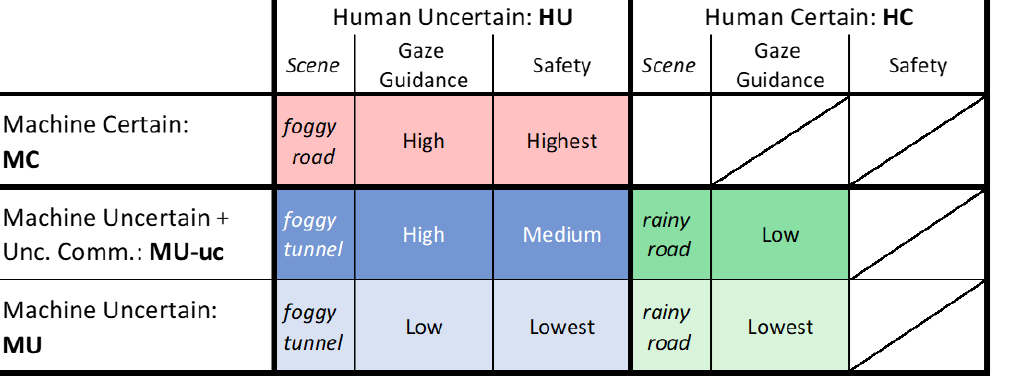
Figure 8. Predicted outcome of behavioral measures according to our research hypotheses when assuming successful experimental manipulations through the introduced conditions. For machine uncertain conditions (blue and green), the light colors mark conditions without uncertainty communication. Their dark counterparts indicate uncertainty